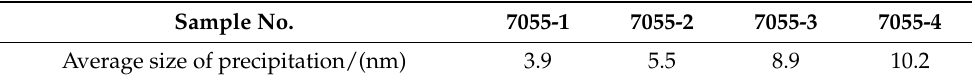
Figure 4. Precipitation measured by TEM: ( a ) 7055-1; ( b ) 7055-2; ( c ) 7055-3; ( d ) 7055-4. Table 4. Average precipitation size of